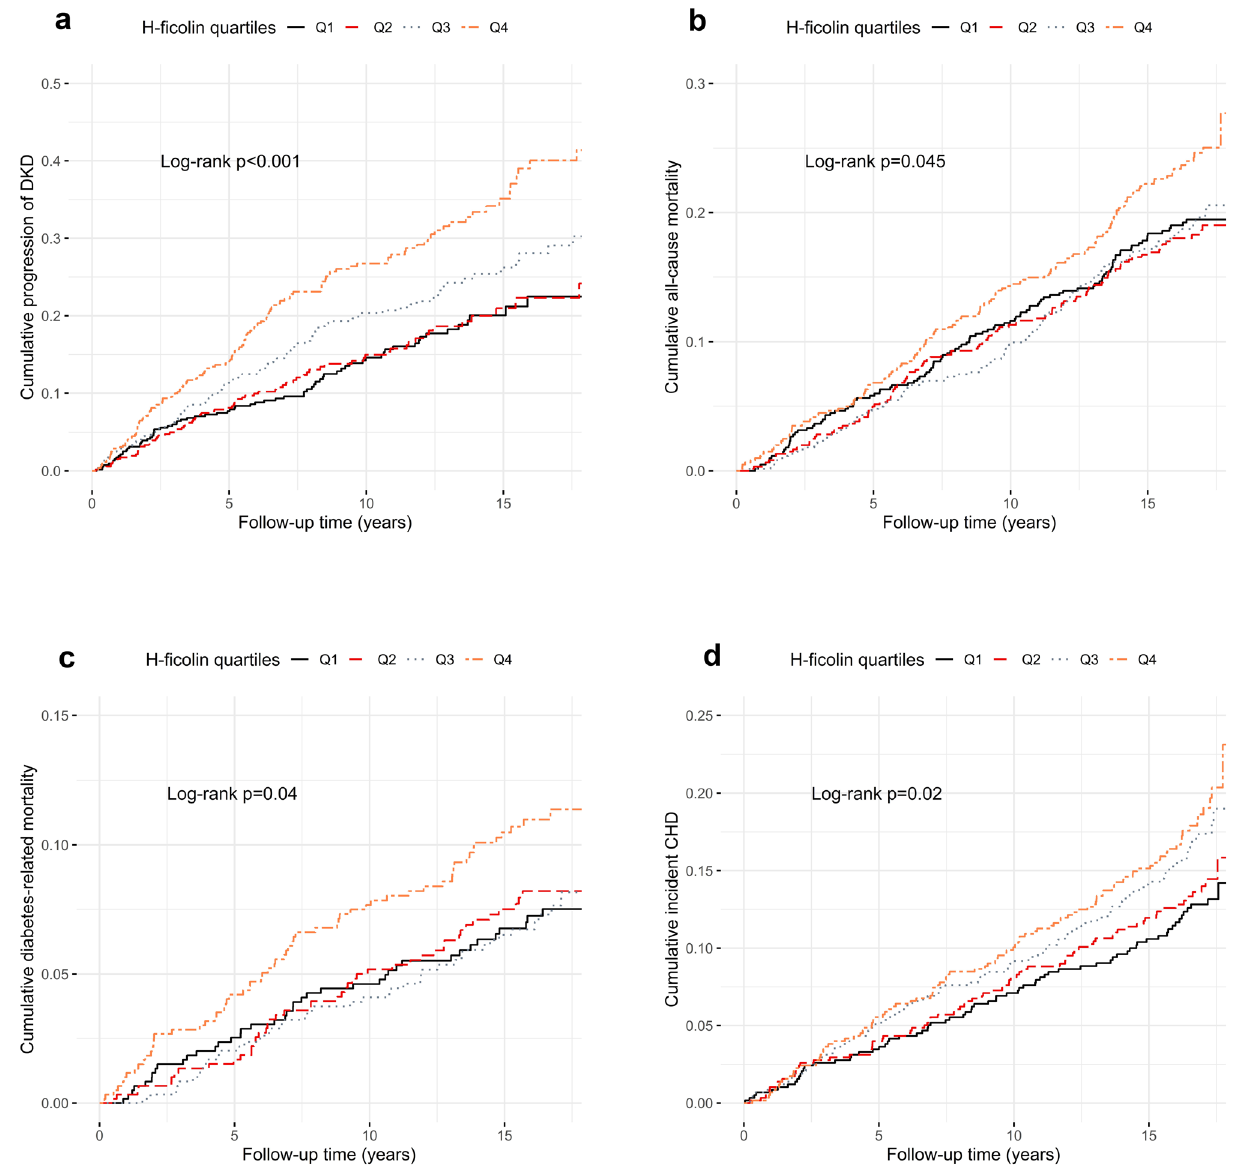
Figure 1. Kaplan–Meier curves, comparing individuals stratified by quartiles of H-ficolin concentration at baseline, with respect to ( a ) progression of diabetic kidney disease (DKD), ( b ) all-cause mortality, ( c ) diabetes- related mortality, and ( d ) coronary heart disease (CHD). Quartile 1 (Q1), black solid line; quartile 2 (Q2), red dashed line; quartile 3 (Q3), grey dotted line; quartile 4 (Q4), orange dot-dashed line.